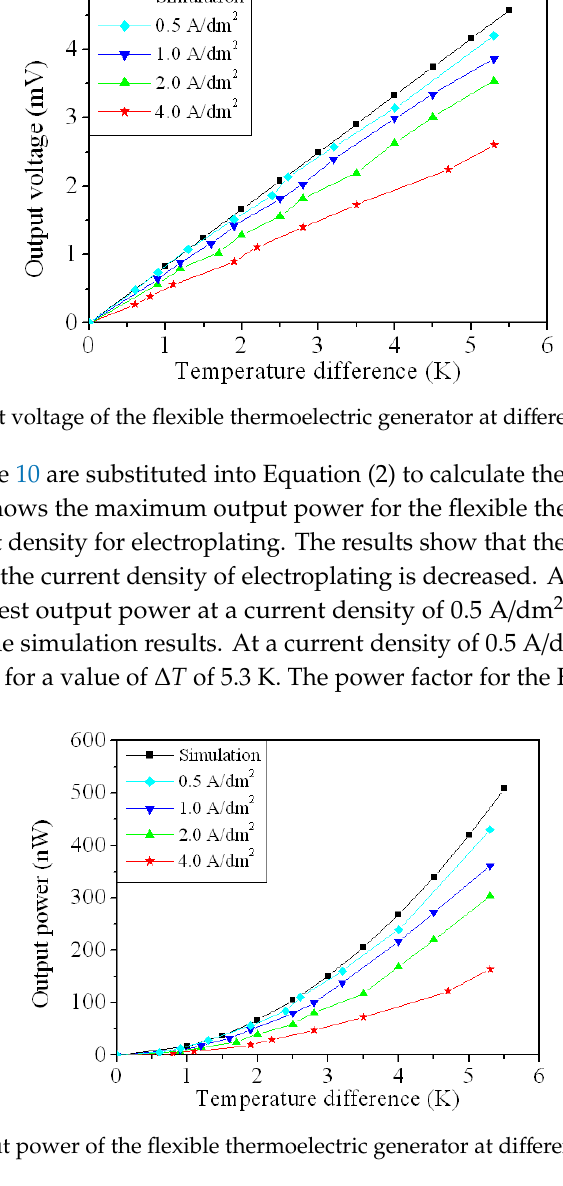
Figure 12. Relationship between resistance and curvature for the FTG. Table 1 lists the performance for various thermoelectric generators. These thermoelectric generators, which were fabricated by Itoigawa [13], Lu [14], Ding [15], Selvan [16], and Jo [17], were flexible. As shown in Table 1, the power factor for the FTG that was produced by Selvan [16] is 66 pW/mm 2 K 2 which is the greatest power factor. The power factor for the FTG that was produced by Lu [14] is 0.064 pW/mm 2 K 2 , which is the lowest power factor. The power factor for the FTG that is produced by this study is 19.5 pW/mm 2 K 2 , which is a higher figure than that for the FTG’s that were produced by Itoigawa [13], Lu [14], Ding [15], and Jo [17]. Table 1. Performances of various thermoelectric generators. Authors